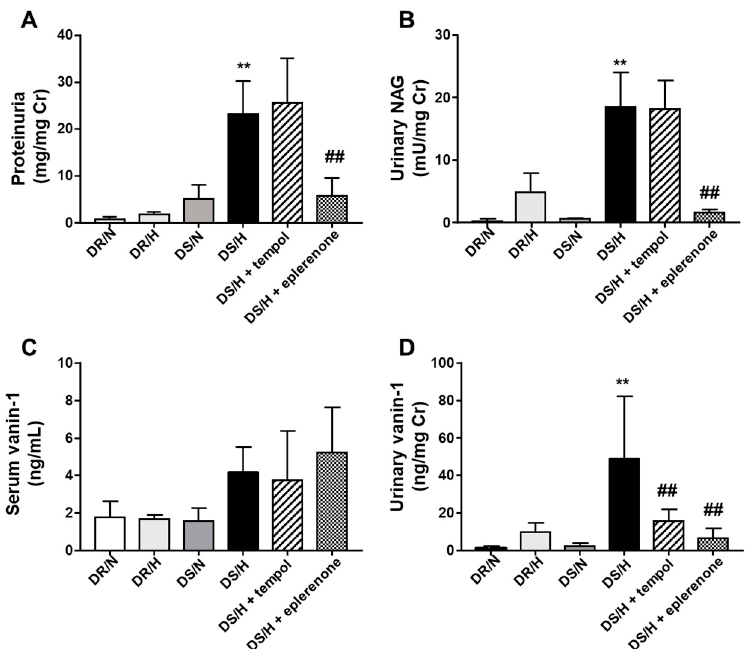
Figure 2. Evaluation of traditional or newly developed biomarkers. At four weeks after normal-salt or high-salt diets, 12 h urine or serum samples were collected for each group ( A – D ). Concentrations of proteinuria, urinary NAG, and urinary vanin-1 were normalized to the urinary creatinine concentration. Values are presented as means ± SE ( n = 6). **, p < 0.01 vs. DS/N rats. ## , p < 0.01 vs. DS/H rats.